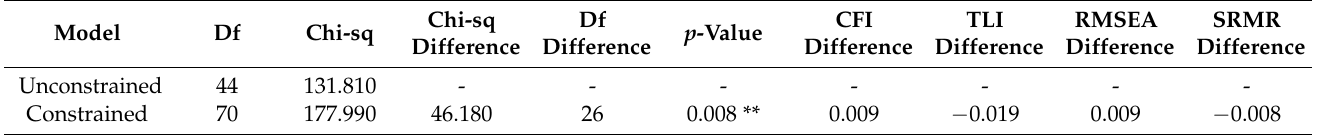
Table 2. Differences between frontline and non-frontline